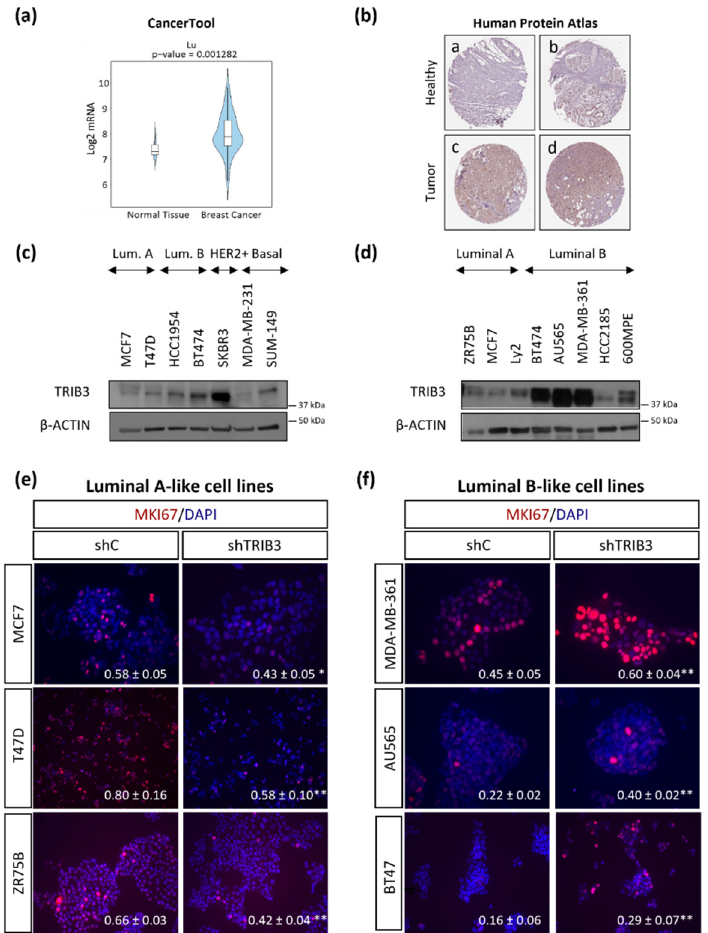
Figure 1. The differential role of TRIB3 in the regulation of luminal A and luminal B breast cancer cell lines: ( a ) Bioinformatic comparison of TRIB3 mRNA levels in published studies from breast cancer and healthy breast tissue (Cancertool platform; n = 131). ( b ) Analysis of TRIB3 protein expression (as determined by immunostaining) in healthy ( a , b : not detected) and tumoral ( c , d : low-intermediate levels) breast tissue. Images (40 × ) were obtained from the Human Protein Atlas database (SIGMA HPA055442 antibody). Representative images are shown. [The human protein atlas indicates that TRIB3 expression in healthy tissue is “not detectable” whereas the expression is “low to intermediate” in breast cancer tissue] ( c , d ) TRIB3 protein levels (as determined by Western blot) in a panel of cell lines that were representative of the different breast cancer subtypes (panel c) or of luminal breast cancer. ( e , f ) Effect of TRIB3 silencing on the proliferation (as determined by immunofluorescence staining with MKI67, red) of luminal A ( e ) and luminal B ( f ) breast cancer cell lines. Representative images (40 × ) are shown. Nuclei were stained with DAPI (blue). The value in the lower right corner of each microphotograph corresponds to the mean fraction ± SEM of the number of MKI67 positive cells with respect to the total number of cells. A total of ten fields per experimental condition were counted to carry out the quantifications ( n = 4–5; * p < 0.05 and ** p < 0.01 with respect to shC cells; using the